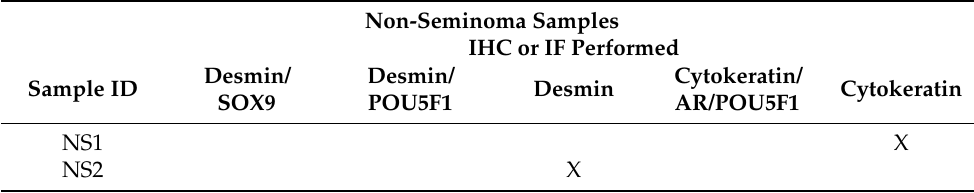
Table A5. Immunohistochemistry and Immunofluorescence performed on non-seminoma